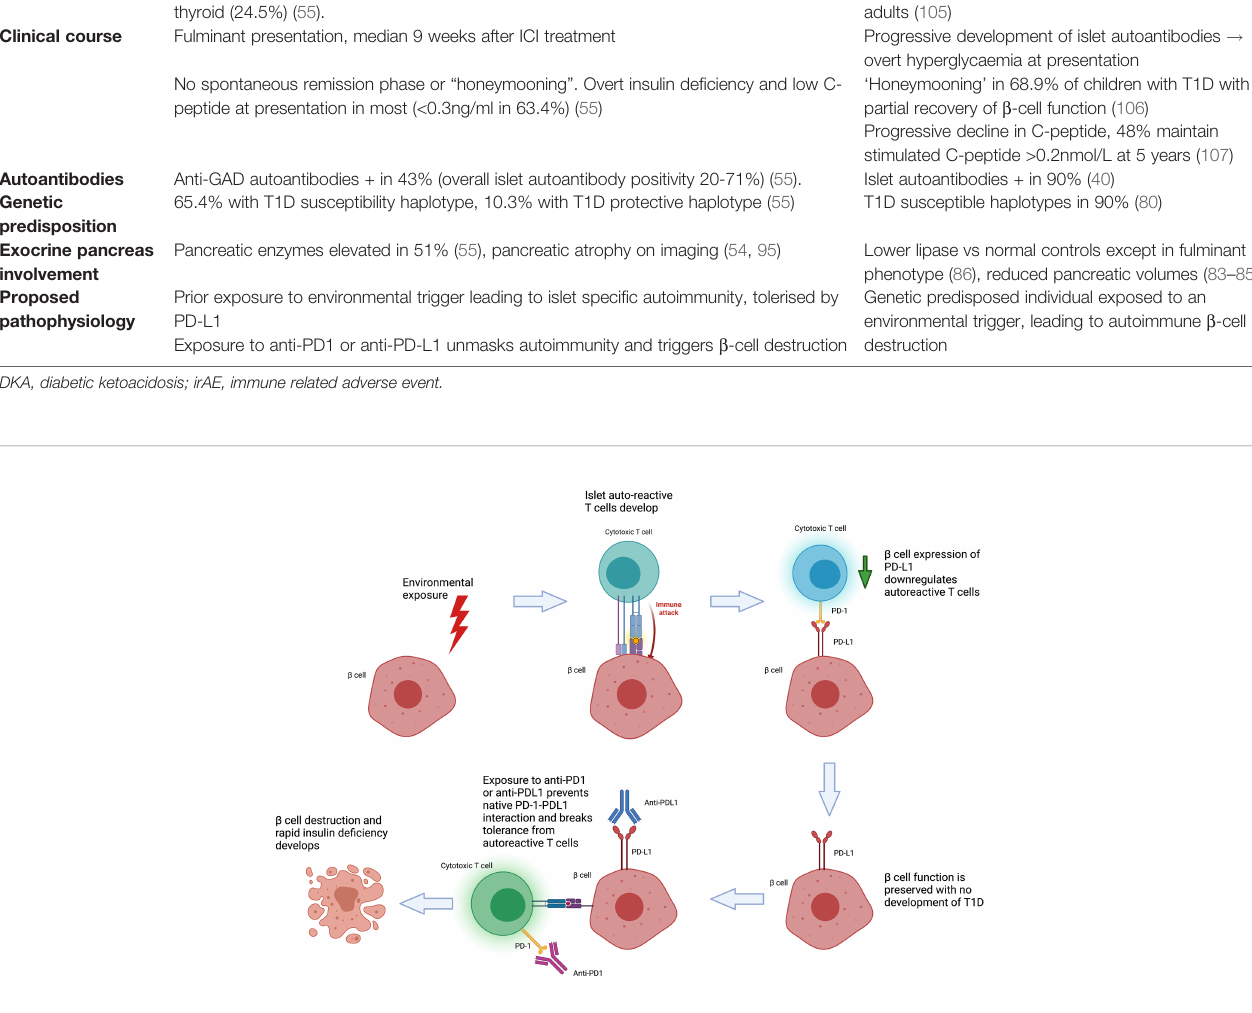
TABLE 1 | Comparison of the disease phenotype of checkpoint inhibitor associated autoimmune diabetes (CIADM) to traditional type 1 diabetes (T1D). CIADM T1D Presentation